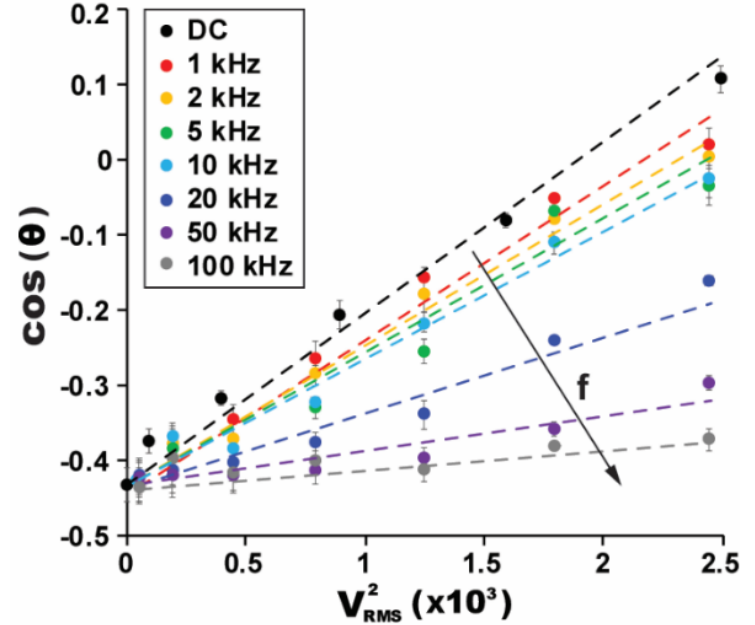
Figure 3. High-frequency AC electrowetting performance varied with AC frequency ( f ) and voltage ( V RMS ). A device was fabricated with an 8.3 µ m gel layer covered with a 150 nm Teflon layer. While varying f and V RMS , the droplet’s contact angle was measured. For the AC frequencies from 1 to 10 kHz, the variations in the slope are not significant. Beyond this frequency, the decreasing trend in the slop is slow.